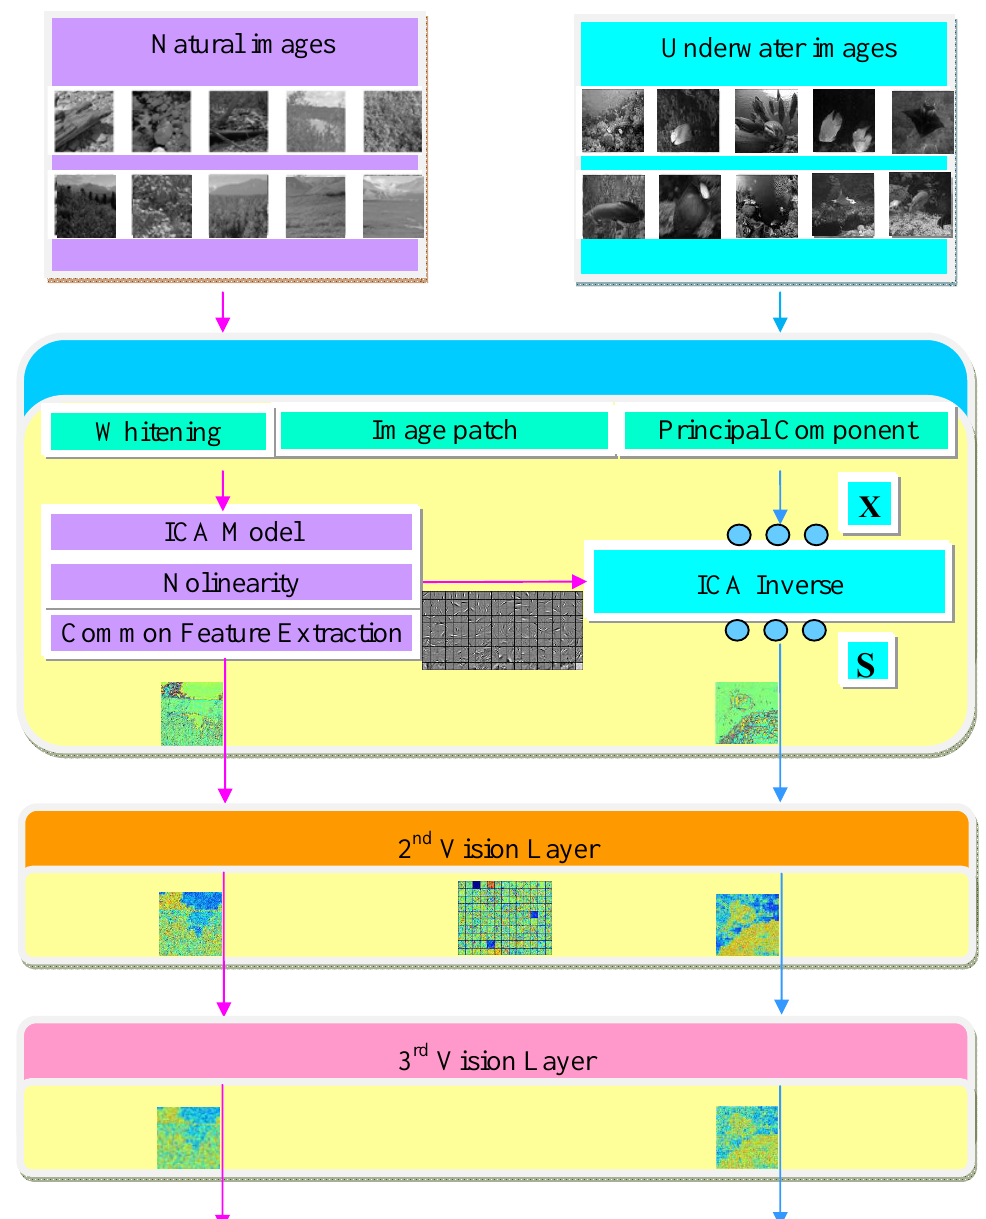
Figure 2. The flow chart of our